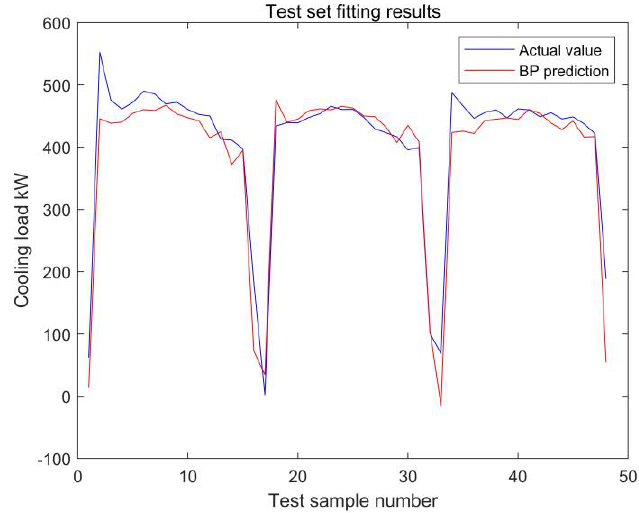
Figure 34. The fitting effect of the test set.